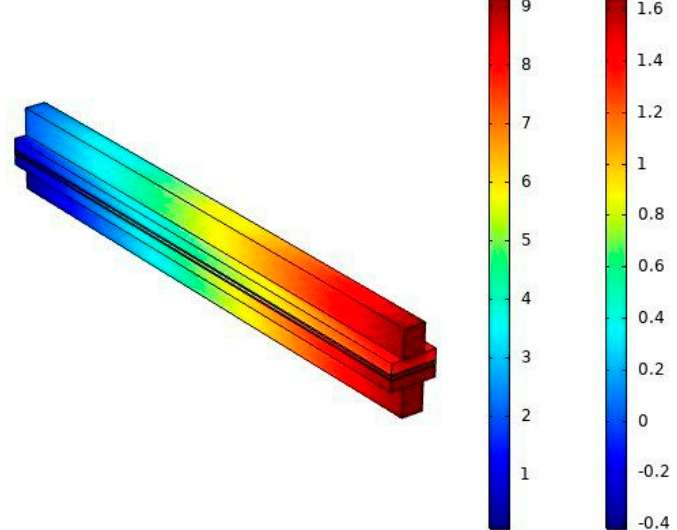
Figure 4. Pressure distribution at the cathode and anode channels at T = 180 ◦ C, P = 1 atm, st a = 1.2, st c = 2 and V = 0.4 V.